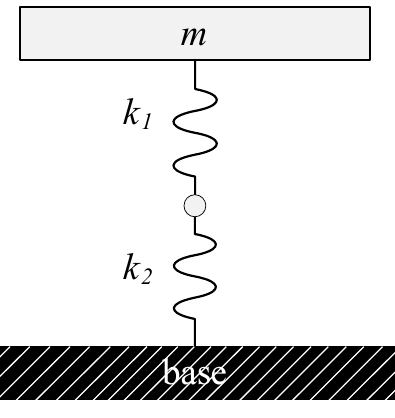
Fig. 2. Schematic diagram of two springs in